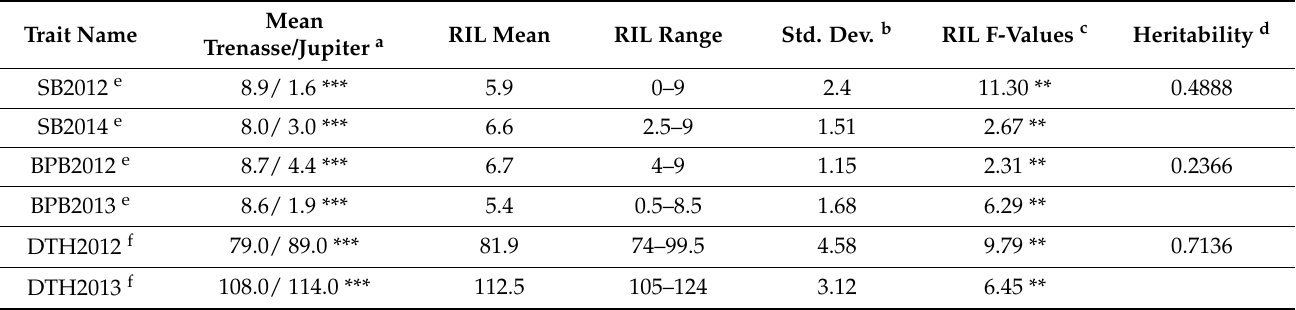
Table 1. Mean values and ranges of phenotypic traits of the parents and the recombinant inbred lines (RILs) for bacterial panicle blight (BPB), sheath blight (SB), and days to 50% heading (DTH).